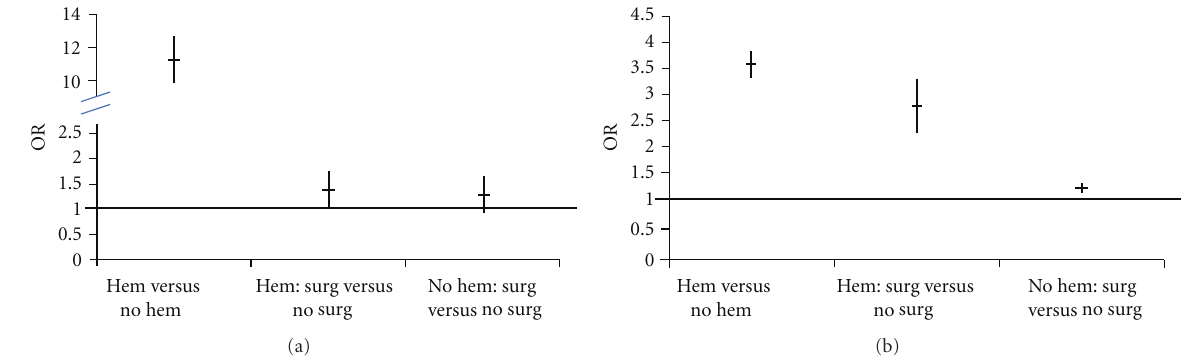
Figure 2: (a) Risk of death. (b) Risk of unfavorable outcome.